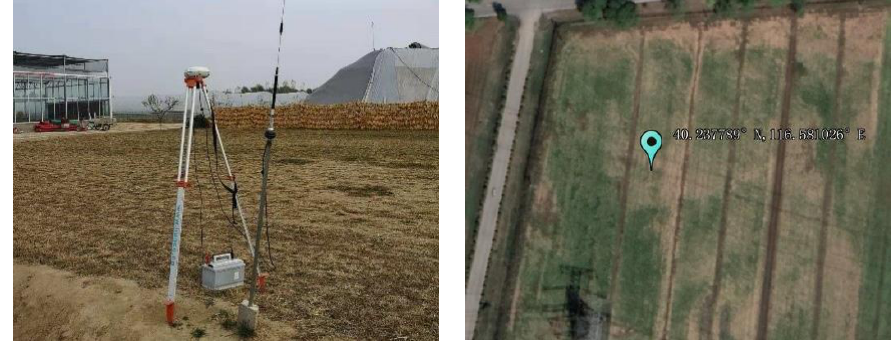
Figure 13. Real-Time Kinematic – Global Navigation Satellite System (RTK-GNSS) base station for field experiments and the experimental field.